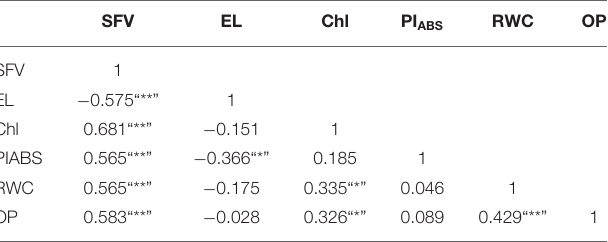
TABLE 1 | Pearson correlation coefficient analysis based on six parameters, namely, mean subordinate function value (SFV), electrolyte leakage (EL), chlorophyll (Chl) content, performance index on absorption basis (PI ABS ), leaf relative water content (RWC), and osmotic potential (OP) among 41 creeping bentgrass accessions under heat